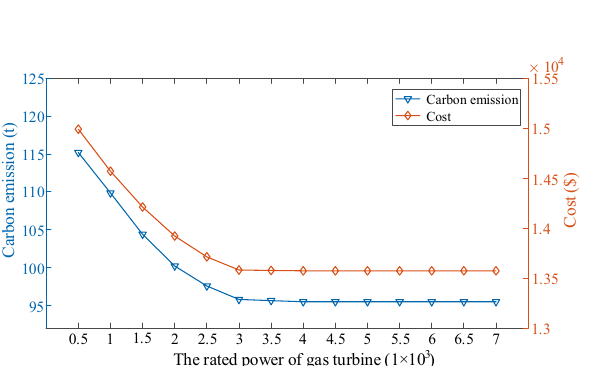
Figure 13. Variation trend of carbon emissions and costs at different v in case 4.